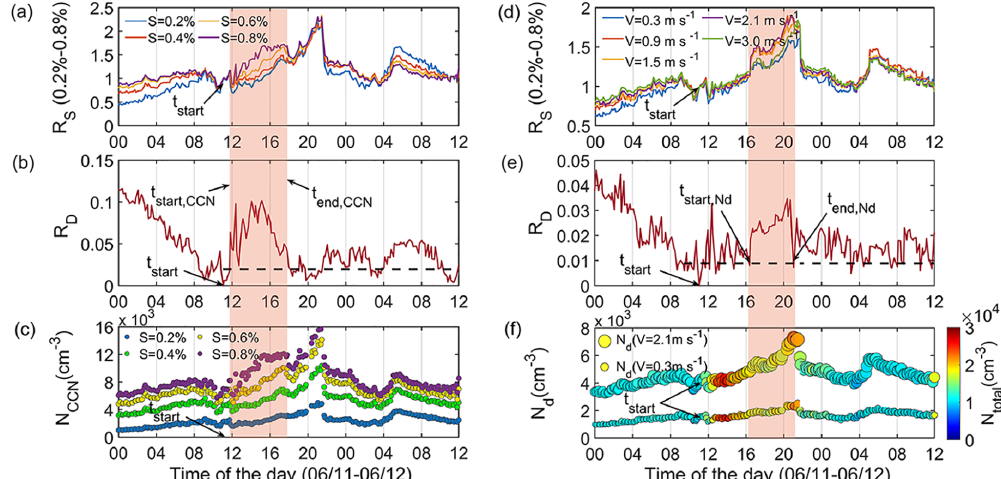
Figure 1. The diurnal evolution of (a) the R S of N CCN at different supersaturations, (b) the relative dispersion of R S and R d , for N CCN at different supersaturations, (c) the calculated N CCN under different supersaturations, (d) the R S of N d under updraft velocities from 0.3 to 3.0ms − 1 , (e) the R d for N d and (f) the calculated N d at updraft velocities of 0.3 and 2.1ms − 1 on 11 June